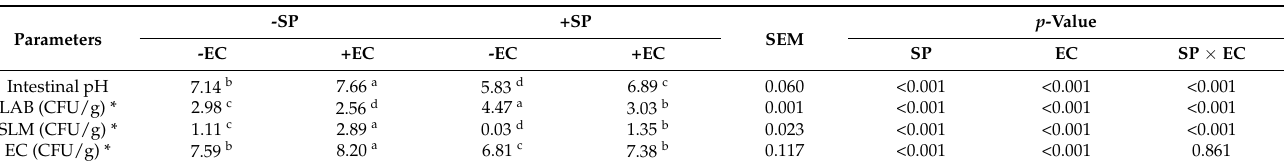
Table 6. Effect of dietary Spirulina platensisis (SP) supplementation on the microbial counts and colon acidosis of broilers challenged by Escherichia coli (EC)